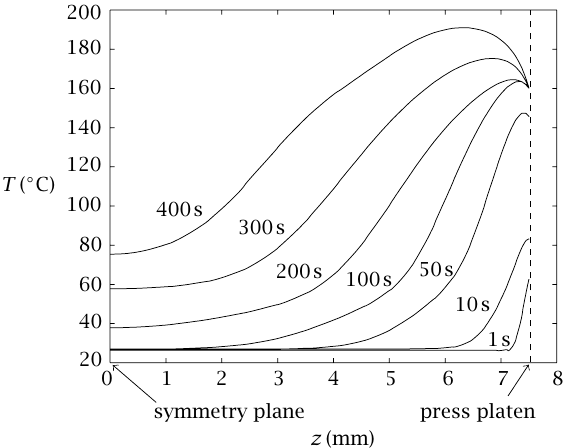
Figure 5.4 . Axial temperature profile at r = R = 0 .